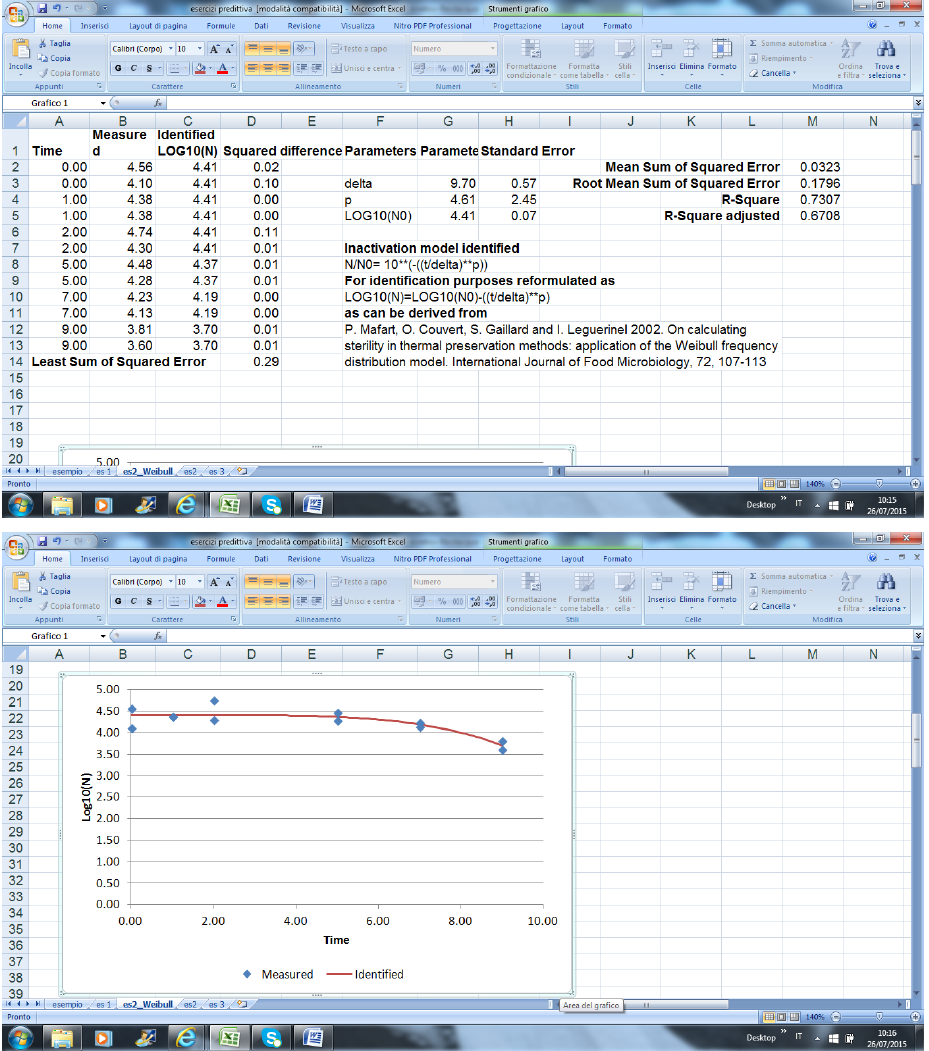
Figure 1. Output of